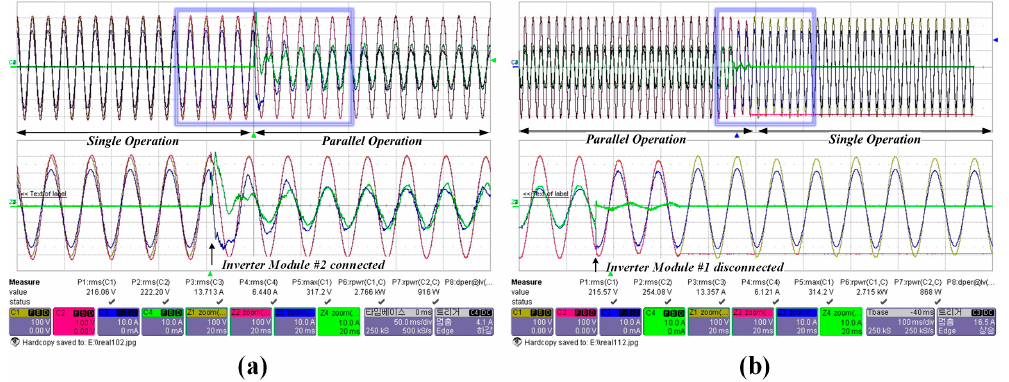
Figure 16. Experimental waveforms of using the proposed control strategy in transient period of inverter module ( a ) connected and ( b ) disconnected without any communication.